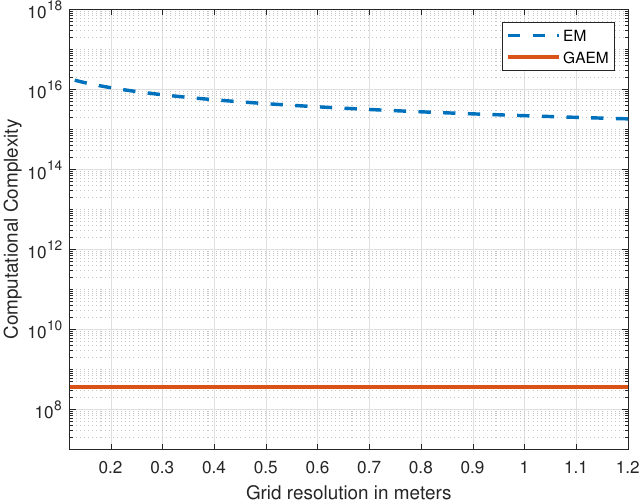
Figure 7. Computational complexity versus grid resolution for the GAEM and traditional